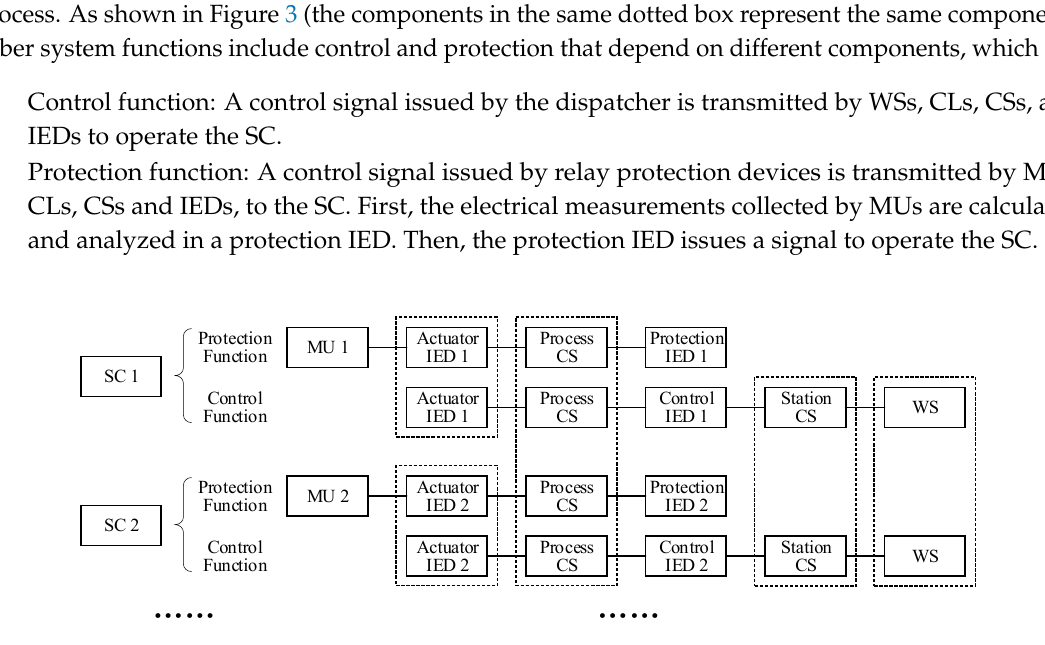
Figure 3. The dependent components of cyber system functions at switchgear components (SCs) in the same substation.